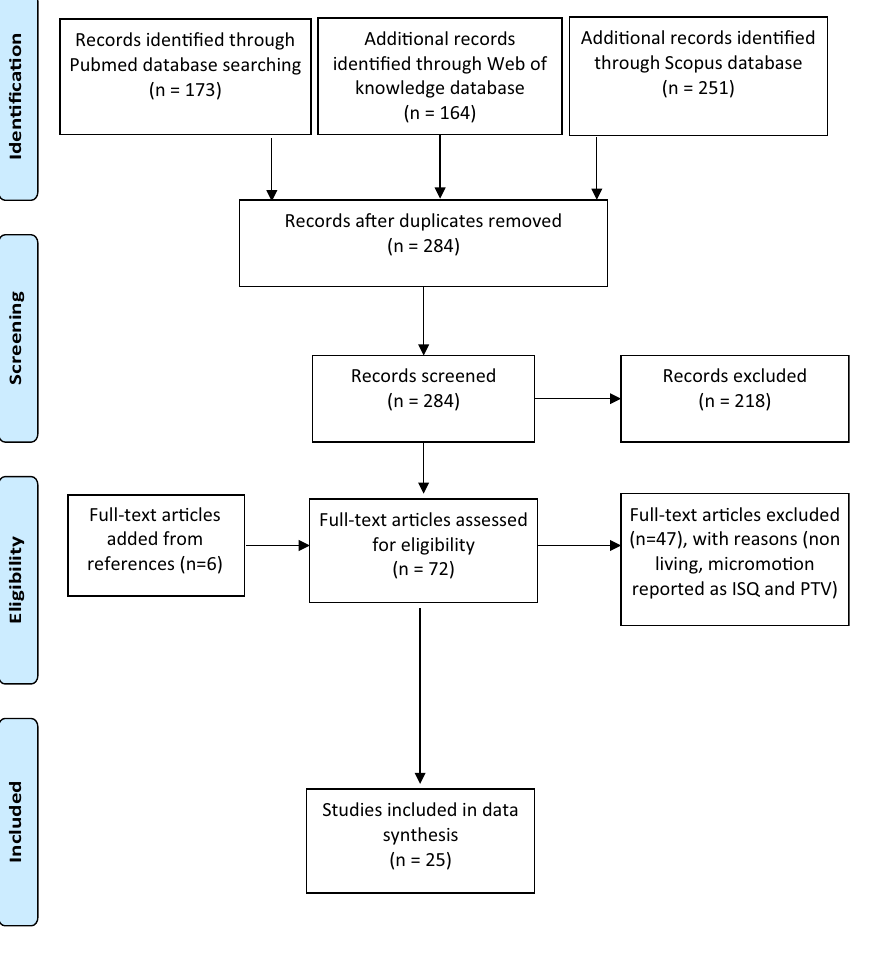
Figure 1. Flowchart of the study selection